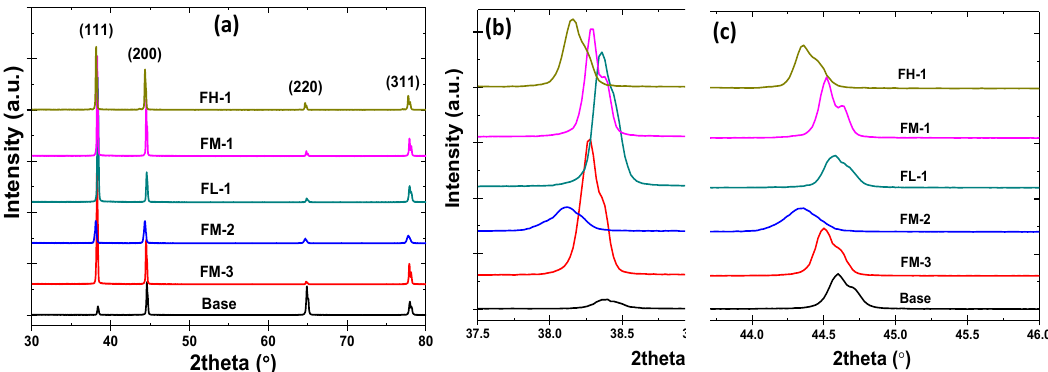
Figure 4. X-ray diffraction patterns: ( a ) all processed samples in comparison with base Al, ( b ) zoom in (111) plane, ( c ) zoom in (200) plane.